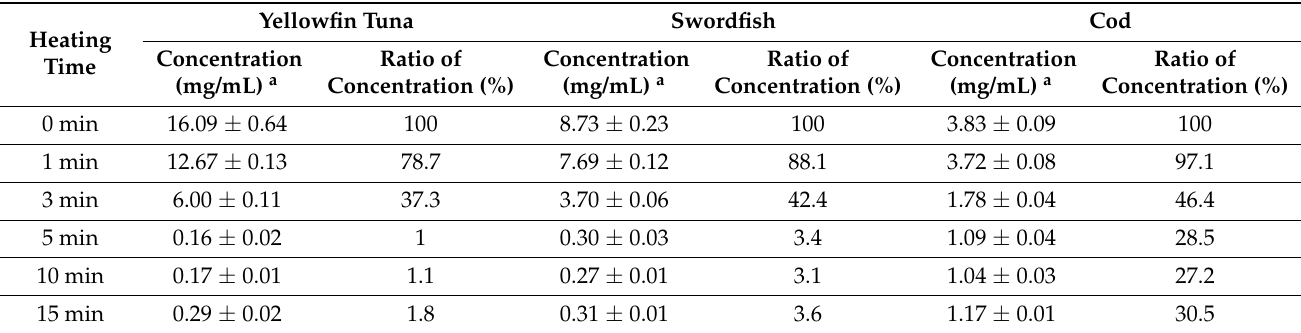
Table 3. Changes in soluble protein concentrations of fish samples (yellowfin tuna, swordfish, cod) with different heating times (0–15